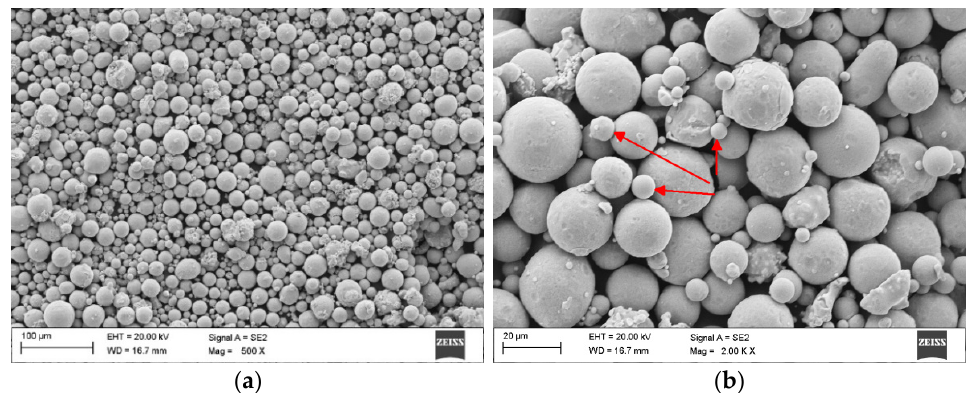
Figure 2. SEM images showing the morphology of the steel powder M789: ( a ) powder particles and ( b ) magnification× 2000, satellites are marked with red arrows.